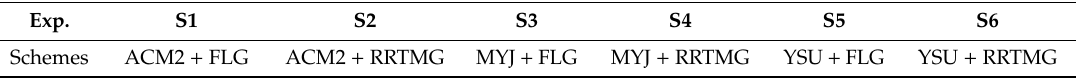
Table 2. Parameterization schemes of numerical